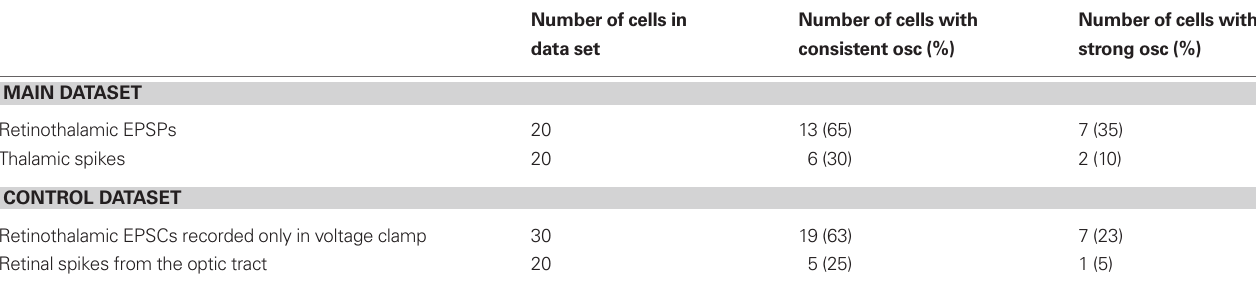
Table 1 | Oscillations in different